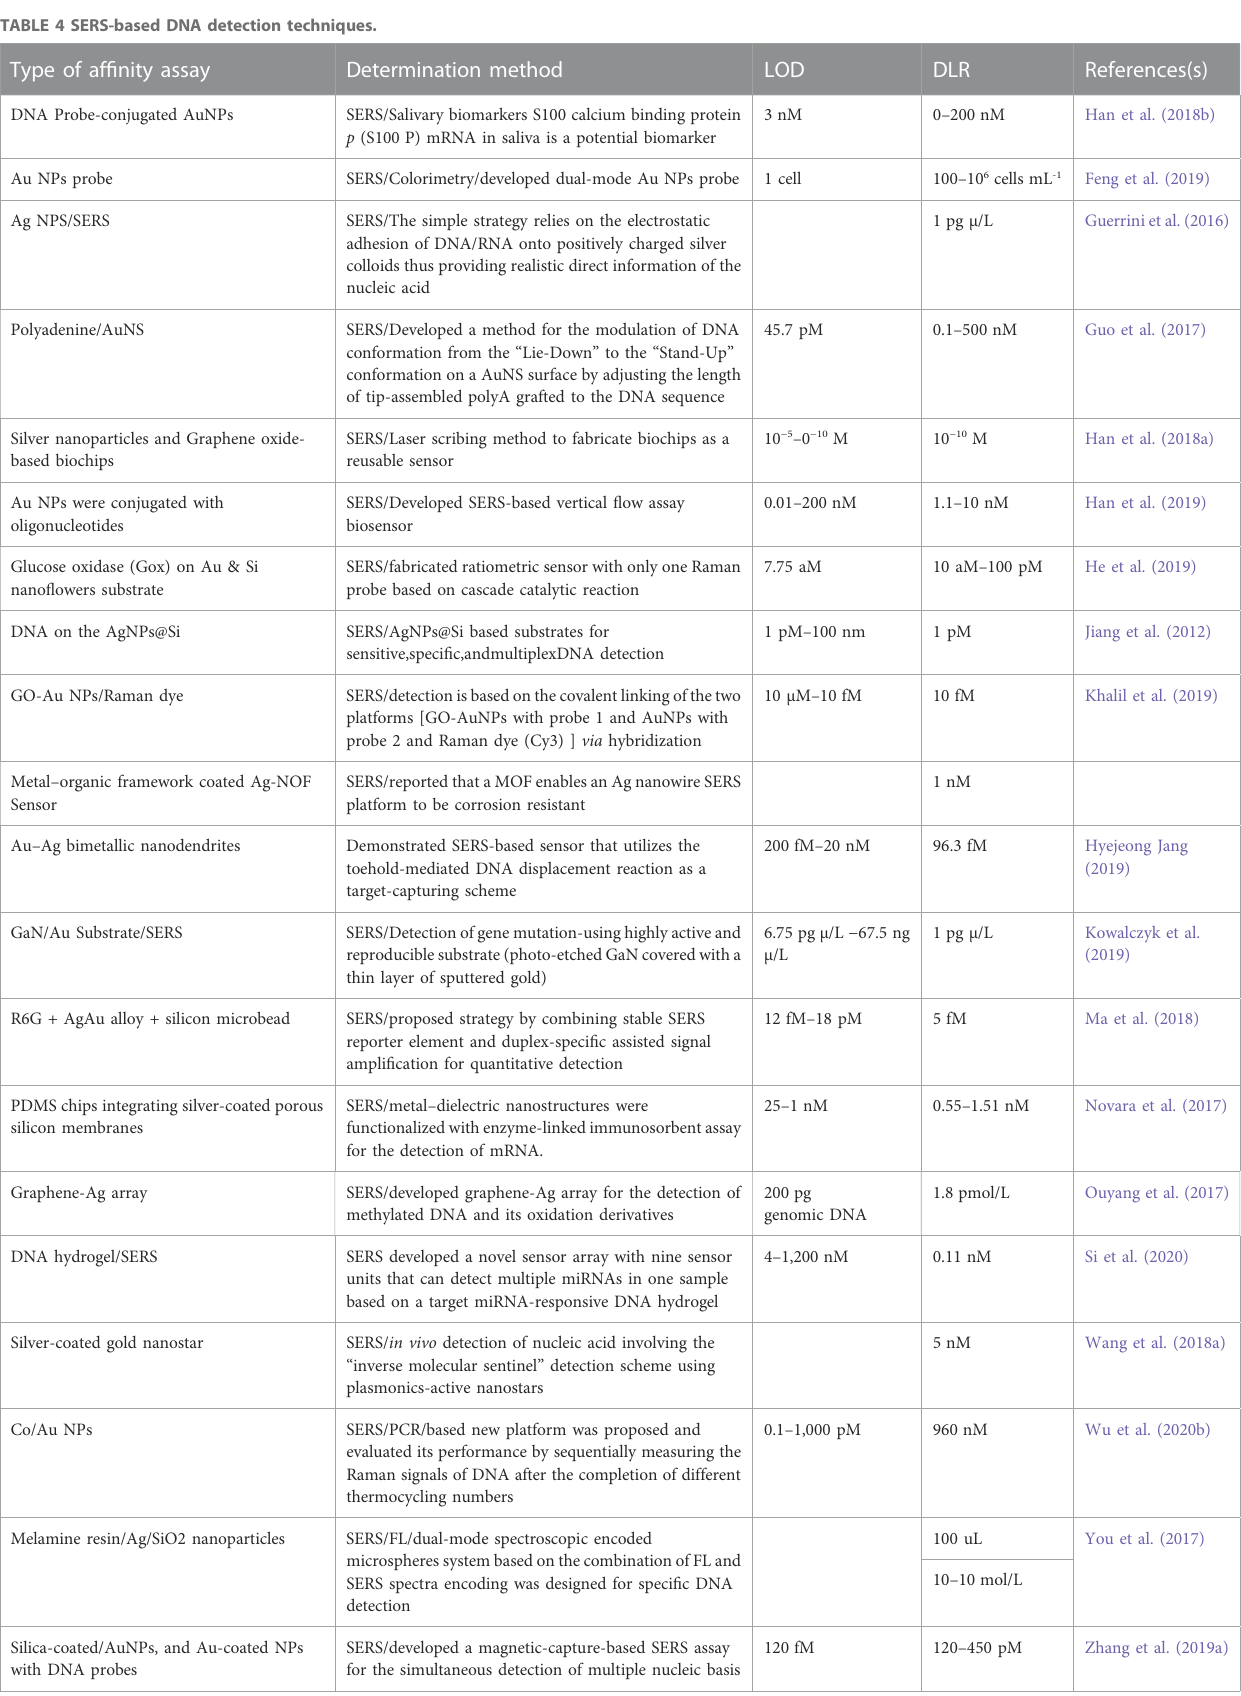
TABLE 4 SERS-based DNA detection